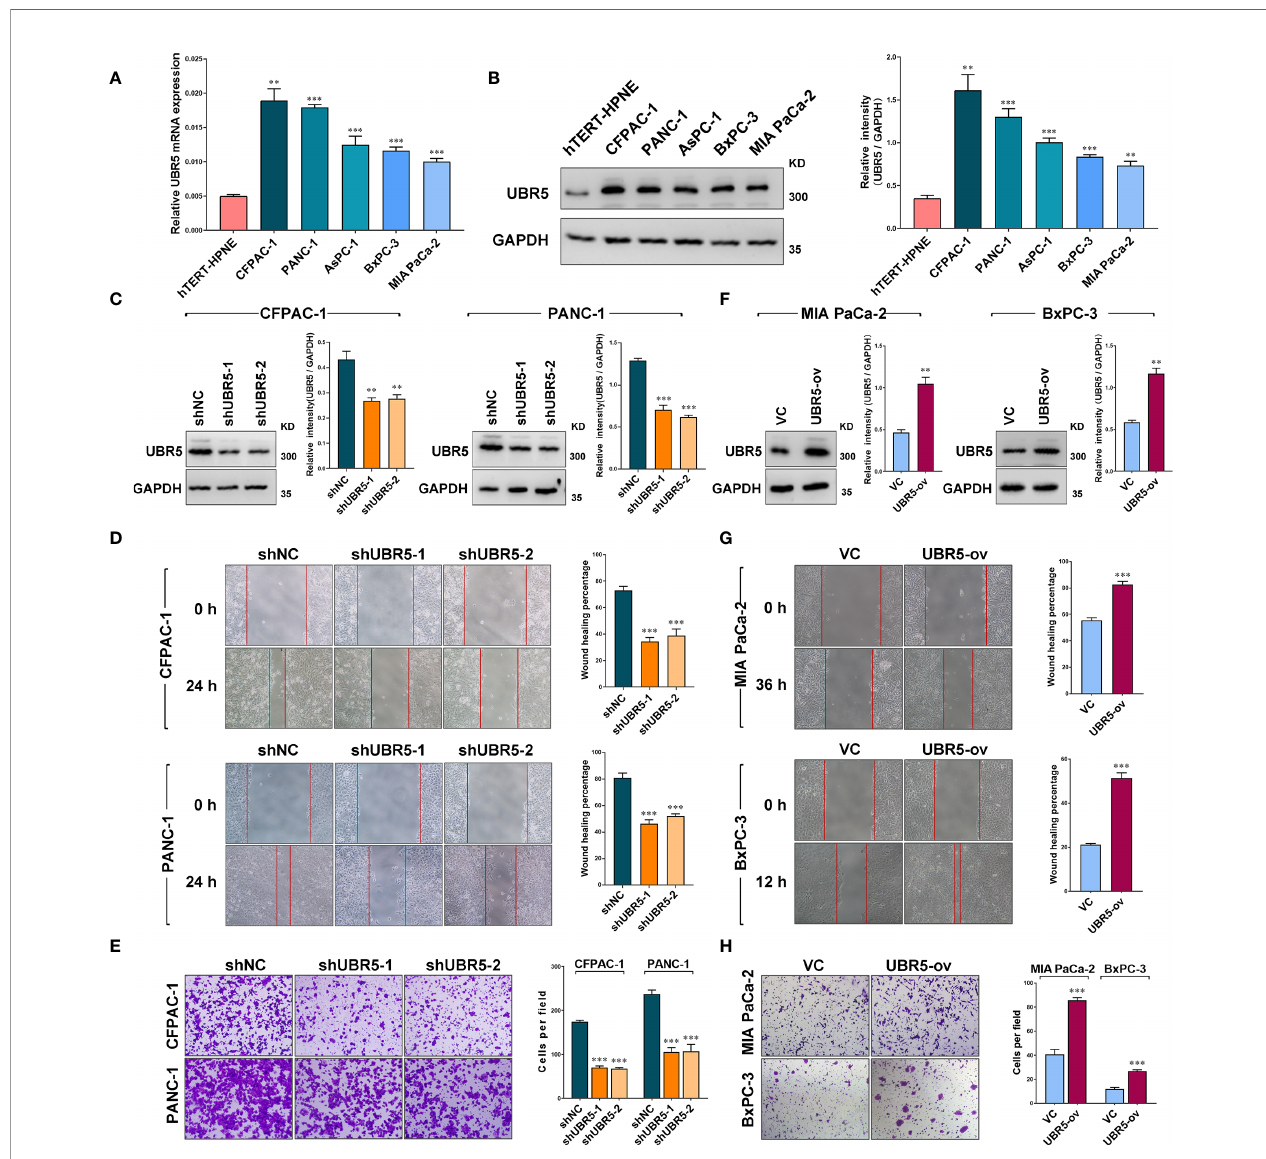
FIGURE 2 | UBR5 promotes pancreatic cancer migration and invasion in vitro. (A) Relative mRNA expression and (B) protein levels of UBR5 in various pancreatic cancer cells and normal pancreatic cells measured by quantitative real-time PCR and western blot separately. The histogram shows the densitometric analysis of the bands. (C) The protein levels of UBR5 in CFPAC-1 and PANC-1 cells after infection with shNC or shUBR5. The histogram shows the densitometric analysis of the bands. (D, E) Wound healing and invasion assays in CFPAC-1 and PANC-1 cells infected with shNC or shUBR5. (F) The UBR5 protein levels in MIA PaCa-2 and BxPC-3 transiently overexpressing UBR5. The histogram shows the densitometric analysis of the bands. (G, H) Wound healing and invasion assays in MIA PaCa-2 and BxPC-3 transiently overexpressing UBR5. Data represents mean ± SEM (n = 3 independent biological repeats). **P<0.01;